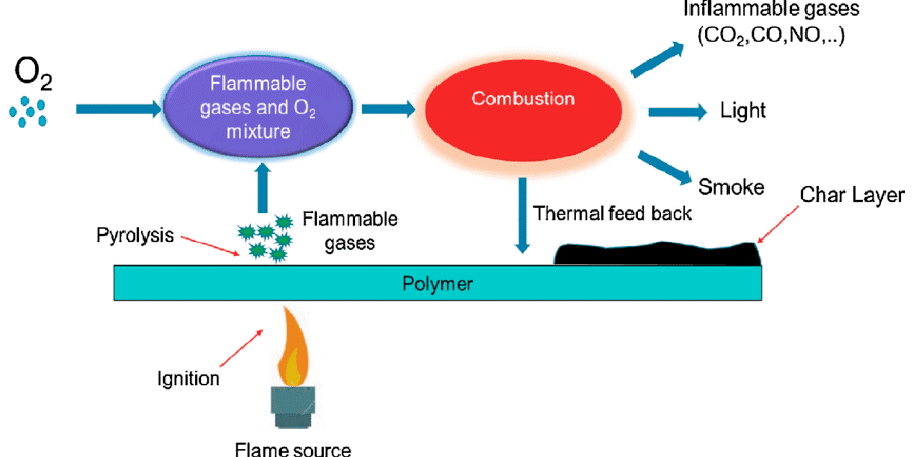
Figure 5. Schematic diagram for the combustion process cycle of polymers.